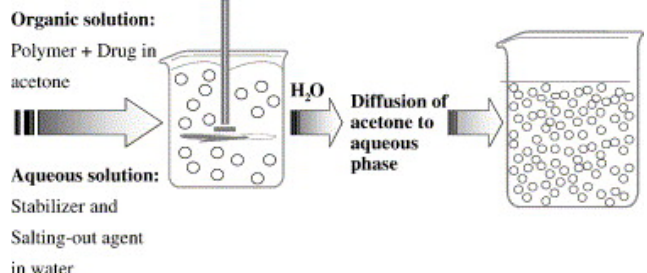
Figure 5. Schematic representation of the salting out technique. Reprinted with permission from Reference [53]. Copyright 2006 Elsevier.